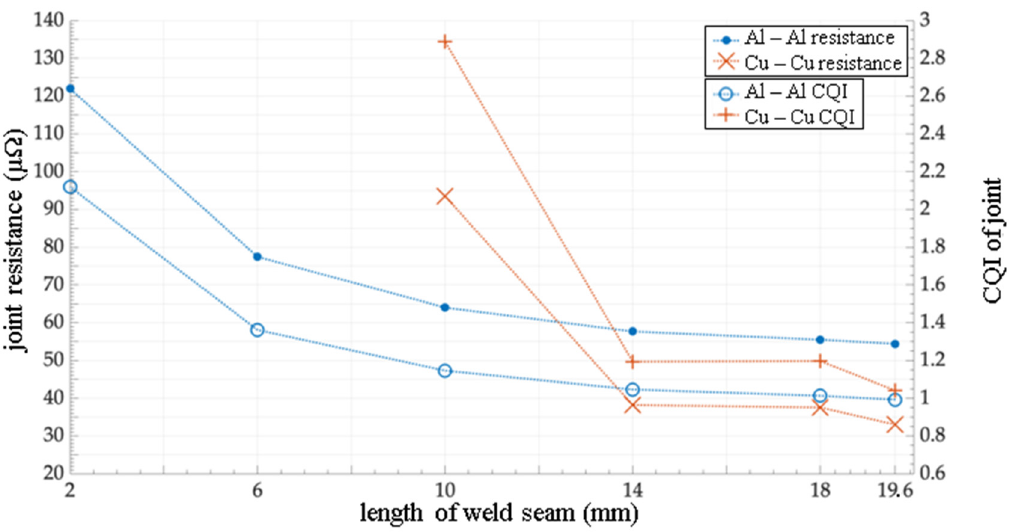
Figure 7. Resistance and CQI of the central weld joints with varying length.